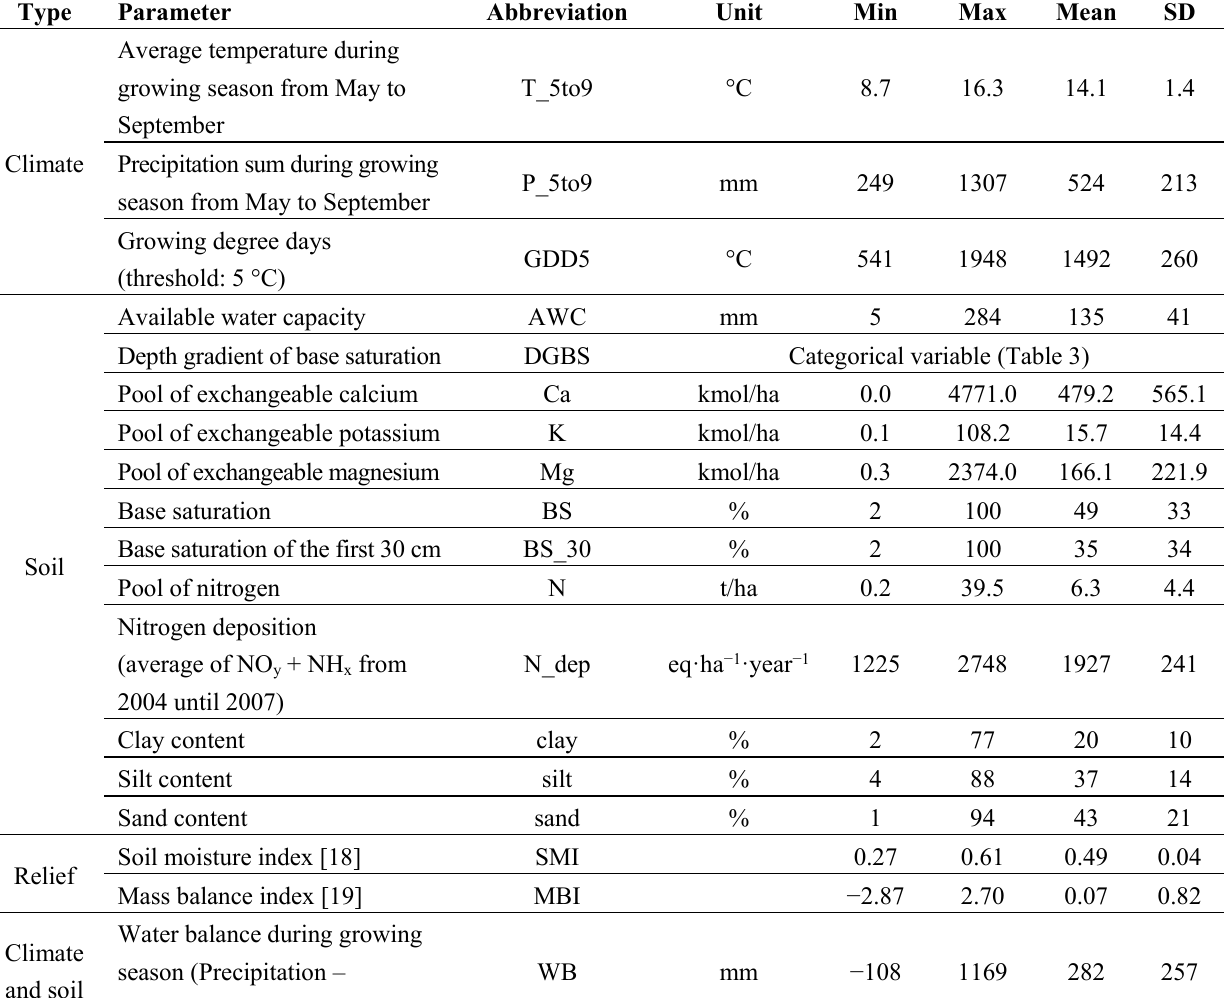
Table 2. Characterization of the environmental variables for Norway spruce plots.